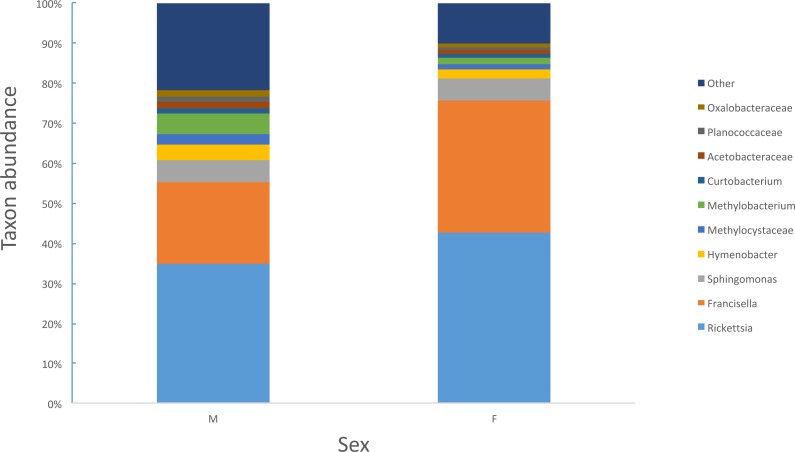
Percent abundance of taxa that comprise at least 1% or greater of the total microbiome in male and female ticks.